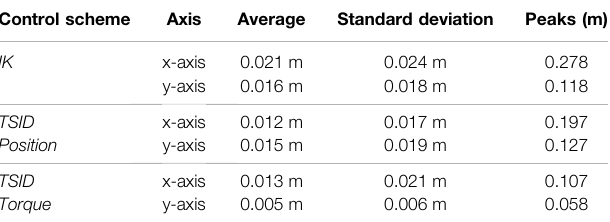
TABLE 4 | ZMP error of the tilted platform simulation.